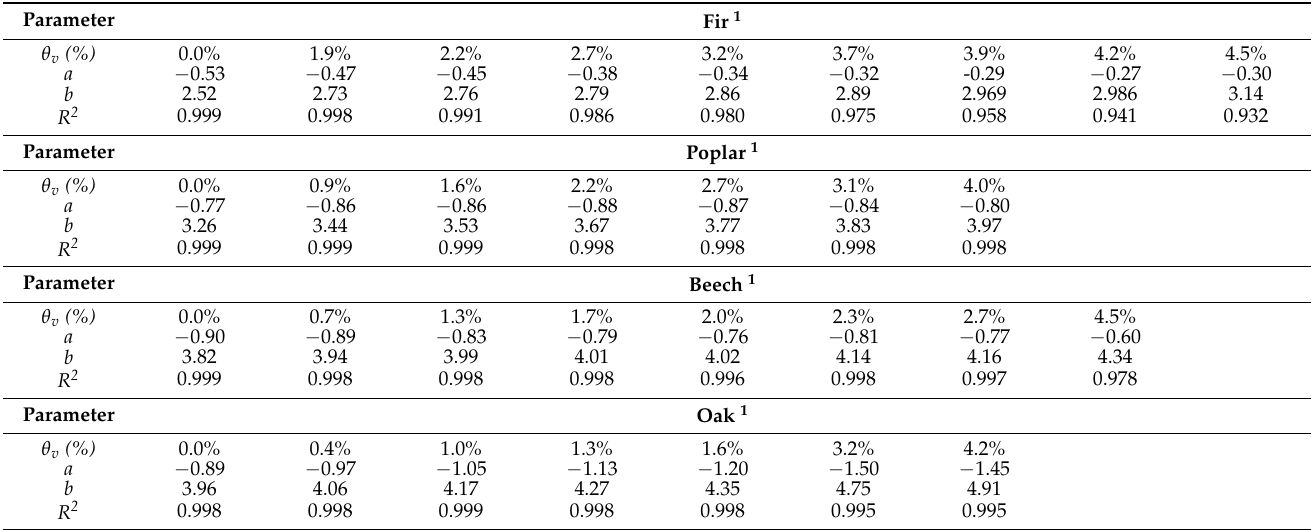
Table 1. Log-fit parameters and coefficient of determination for the wood samples at different levels of water content.